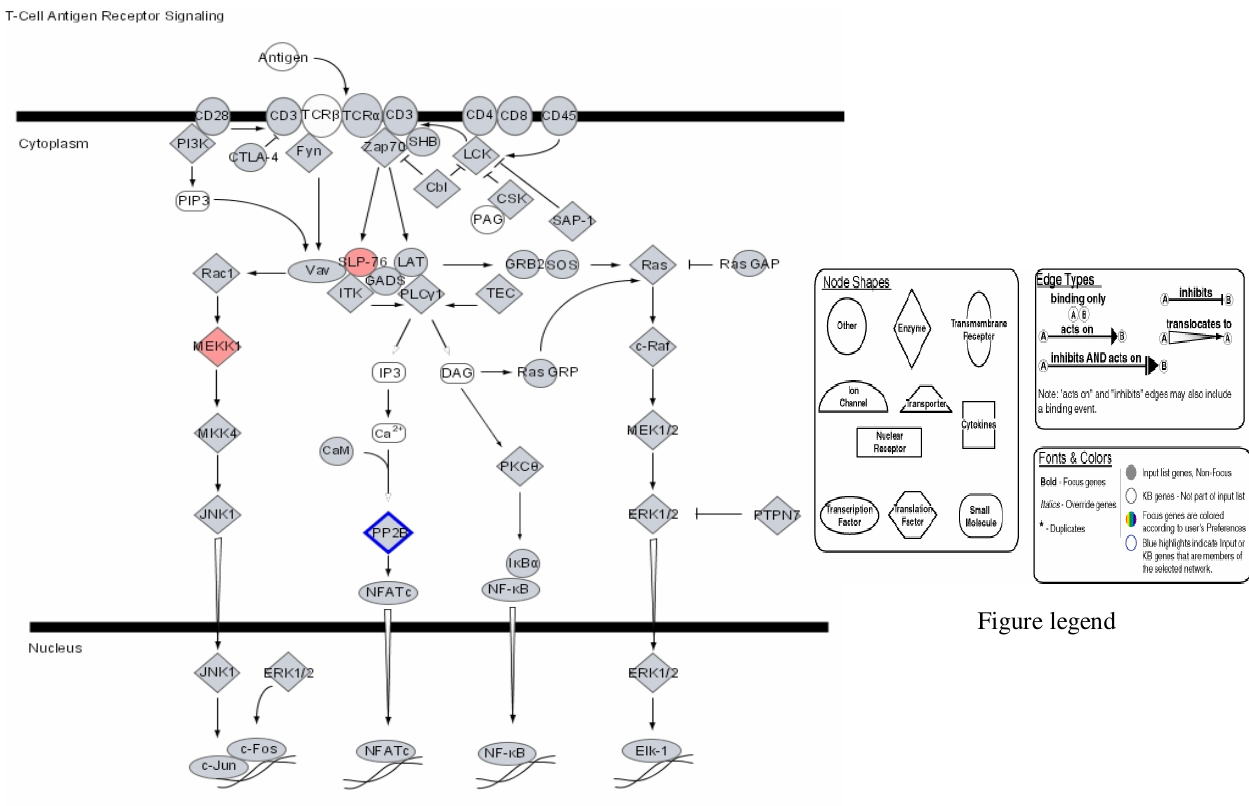
Figure 4: Modulation of T-Cell antigen receptor signalling by mercury : Activation of SLP-76 and MEKK, and repression of